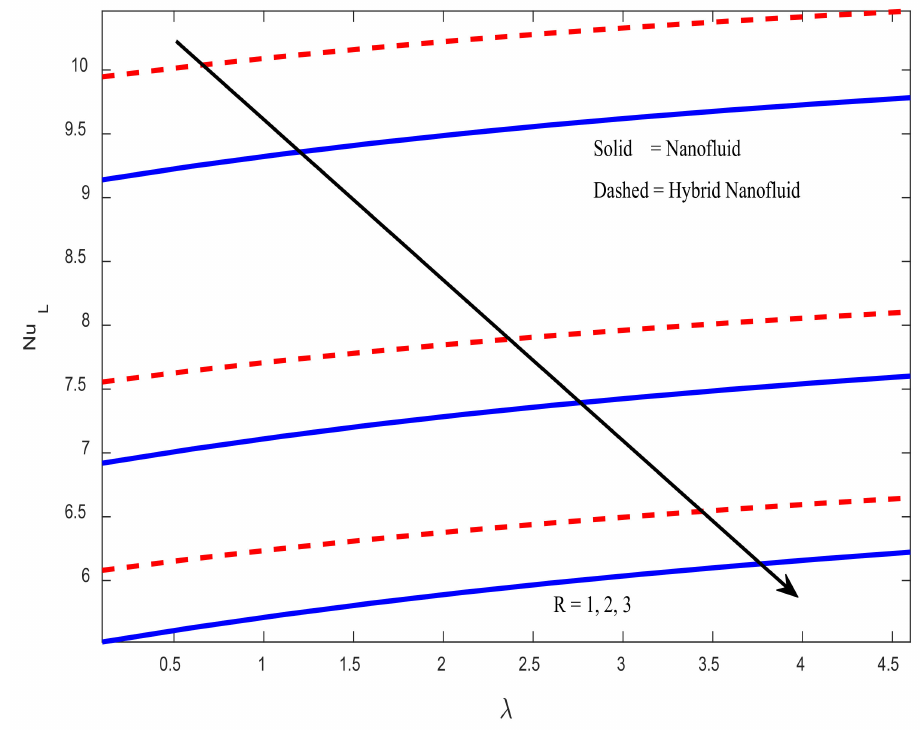
Figure 13. Influence of R on heat transfer rate near the lower